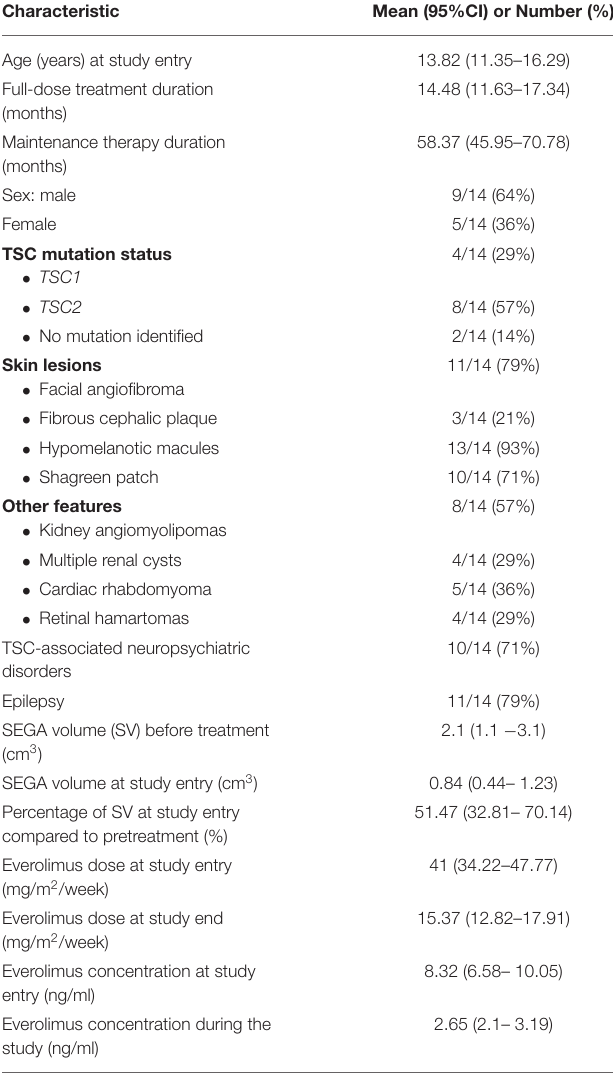
TABLE 1 | The clinical characteristics of the patients.